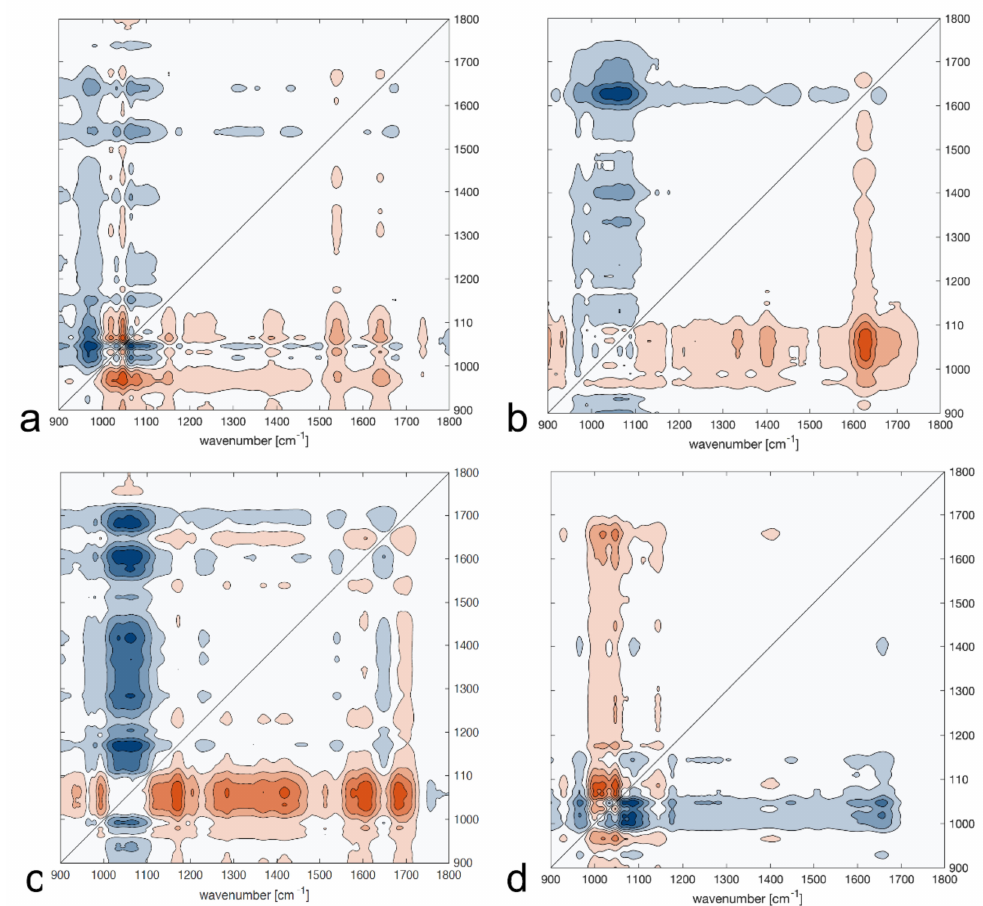
Figure 6. Asynchronous maps for bee pollen samples collected on different dates: ( a ) 2 June 2019 (P2); ( b ) 14 June 2019 (P3); ( c ) 29 June 2019 (P4), and ( d ) 20 July 2019 (P5) generated using sample P1 (from 12 August 2018) as a reference. The peaks with the positive sign are orange, and the negative peaks are